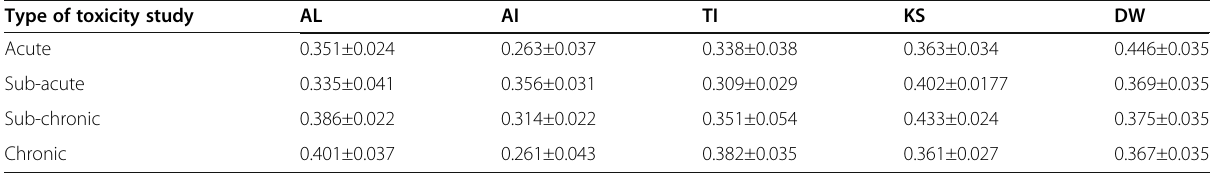
Table 3 Effects of short, medium and long term oral administration of extracts of four ethnomedicinal plants in rats on kidney organosomatic